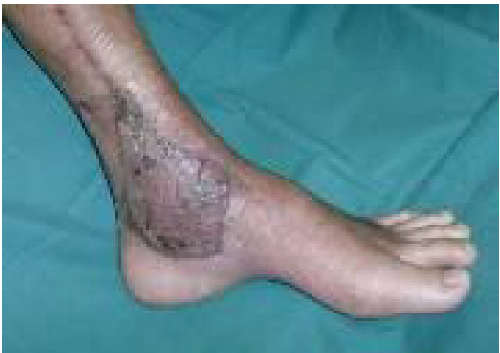
Figure 18. Healed SSG 8 weeks post-operation